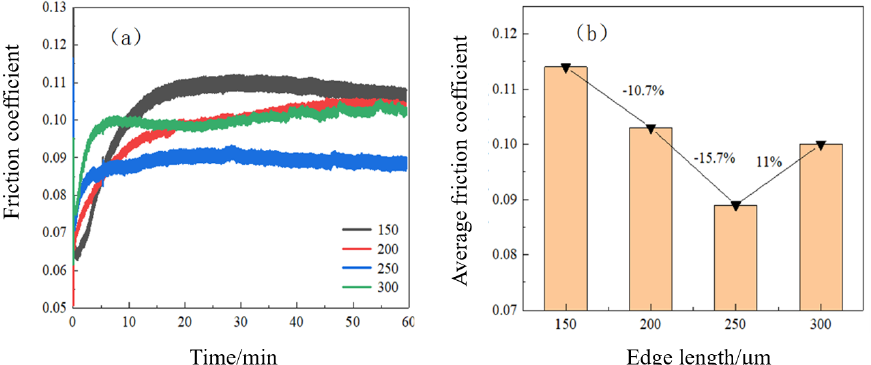
Figure 24. Influence of side length on surface friction coefficient. ( a ) Friction coefficient curve, ( b ) Average friction coefficient. ( b ) Average friction